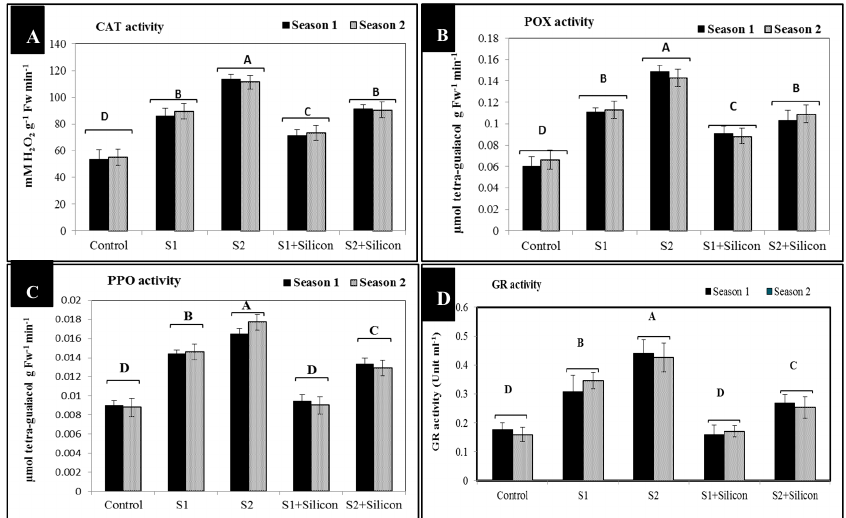
Figure 3. Activities of catalase (CAT) ( A ), peroxidase (POX) ( B ), polyphenol oxidase (PPO) ( C ) and glutathione reductase (GR) ( D ) as affected by silicon in salt-stressed sweet pepper plants in the 2018 and 2019 seasons. S1: Salinity at 1500 ppm, S2: Salinity at 3000 ppm.